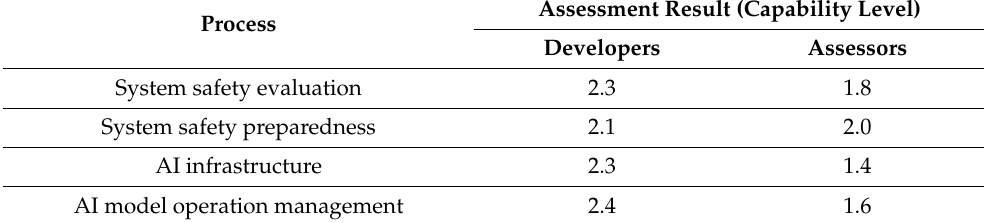
Table 8. Maturity levels, development periods, and number of developers of 13 AI projects.